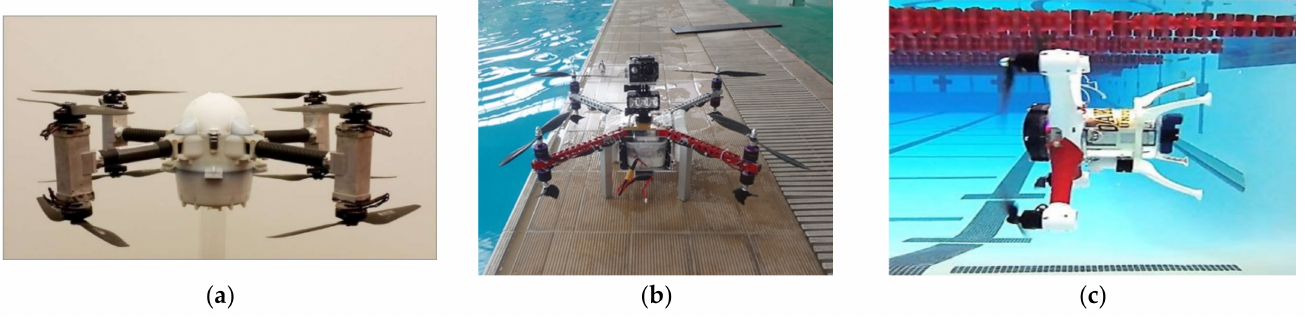
Figure 4. The multirotor configuration of an HAUV. ( a ) Maia’s team; ( b ) Feng’s team; ( c ) Alzu’Bi’s